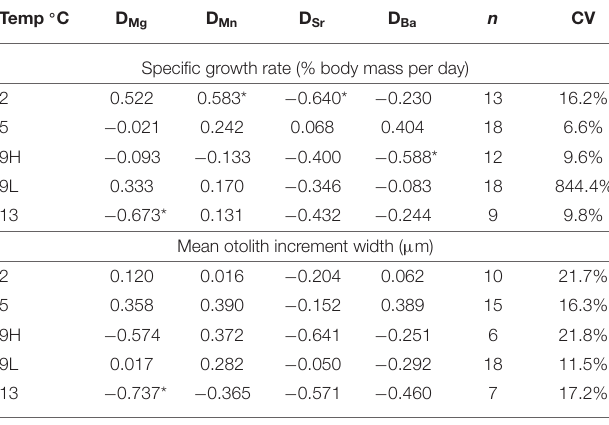
TABLE 6 | Correlation coefficients between D Me and specific growth rate (SGR, % body mass per day) and partition coefficients (D Me ) for fish within the same